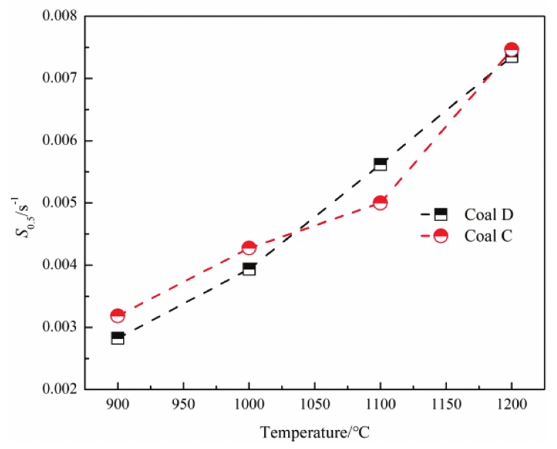
Figure 6: Relationship between the pyrolysis parameter S 0.5 and curves of lump coals at the same temperature were com- pared, as shown in Figure 7.